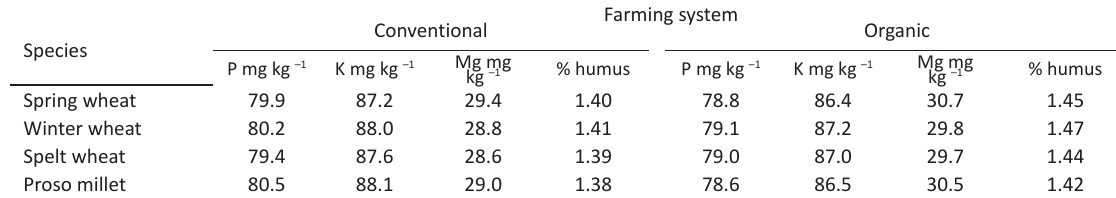
Farming system Conventional